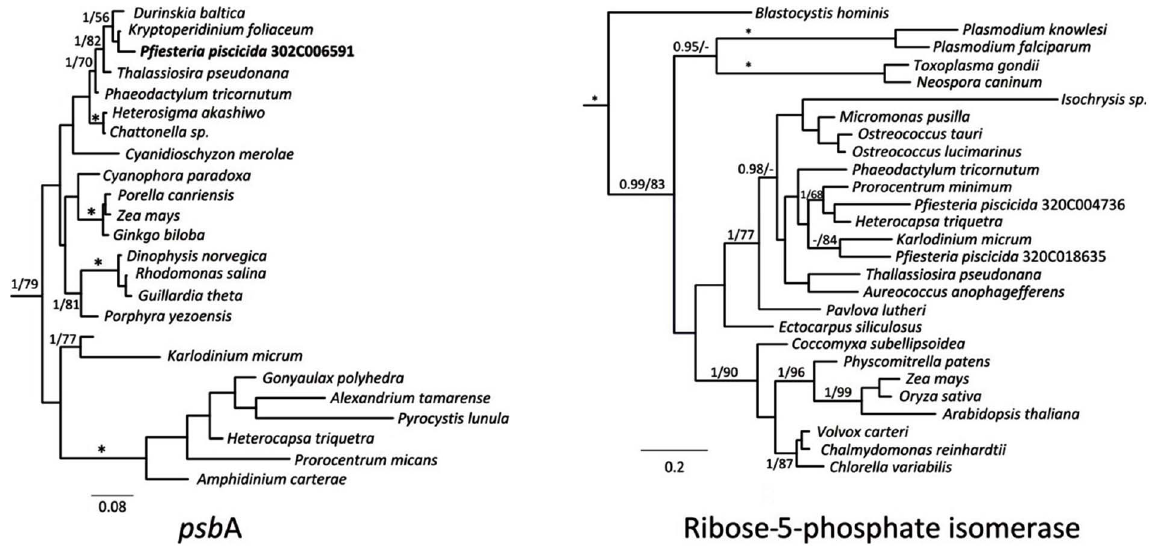
Figure 3. Maximum likelihood trees ( RaXML, WAG + I + C model ) inferred from Pfiesteriapiscicida protein sequences and assorted plastid endosymbiont lineages. psb A protein – alignment length 282 amino acids. Ribose-5-phosphate isomerase protein – alignment length 231 amino acids. Numbers above nodes indicate posterior probabilities and RAXML bootstrap percentages. *=1.00 PP and 100% RAxML BP. Values , 50% are not shown.